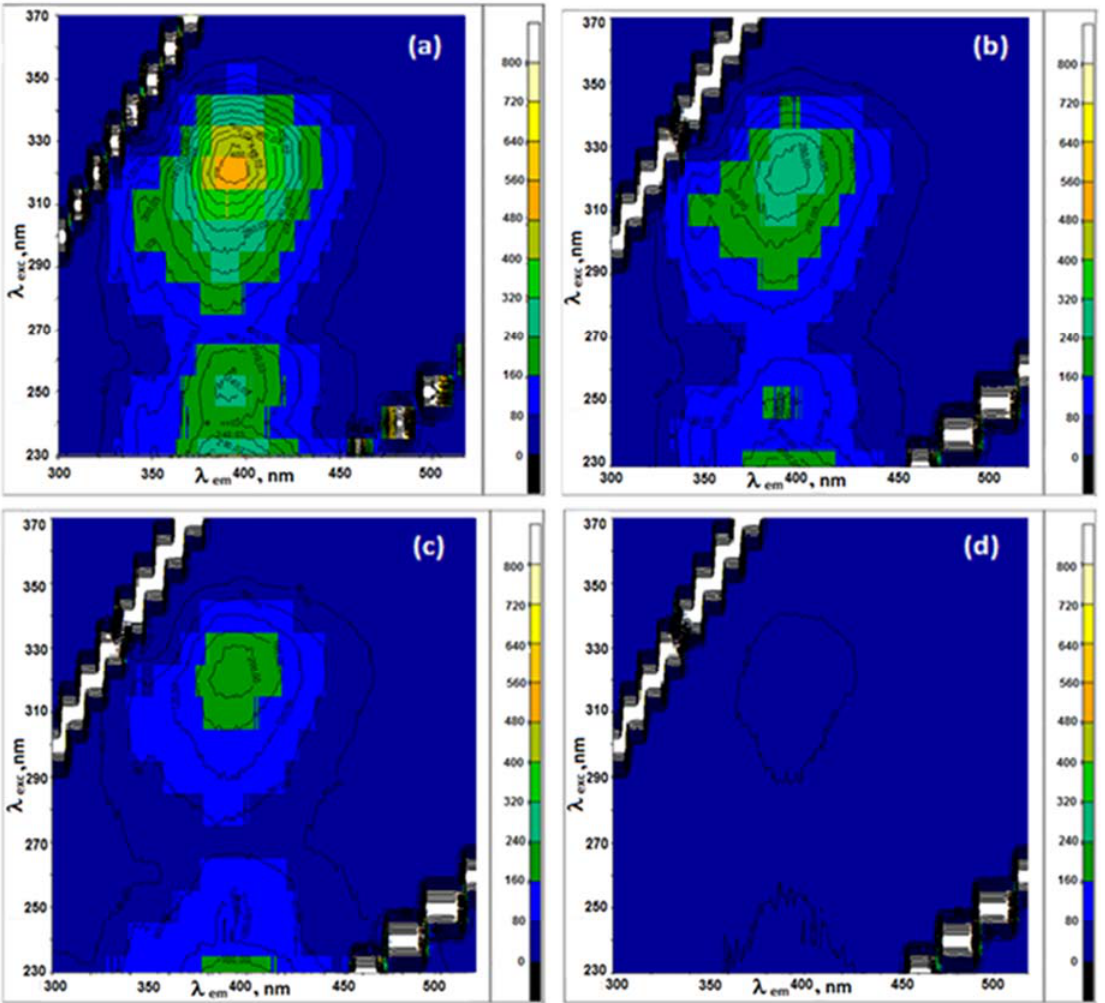
Figure 6. 3D contour maps of pyridoxine in ( a ) 20 mM CTAB and G dispersions in 20 mM CTAB: 0.5 wt % ( b ), 1 wt % ( c ), and 2 wt % ( d ).